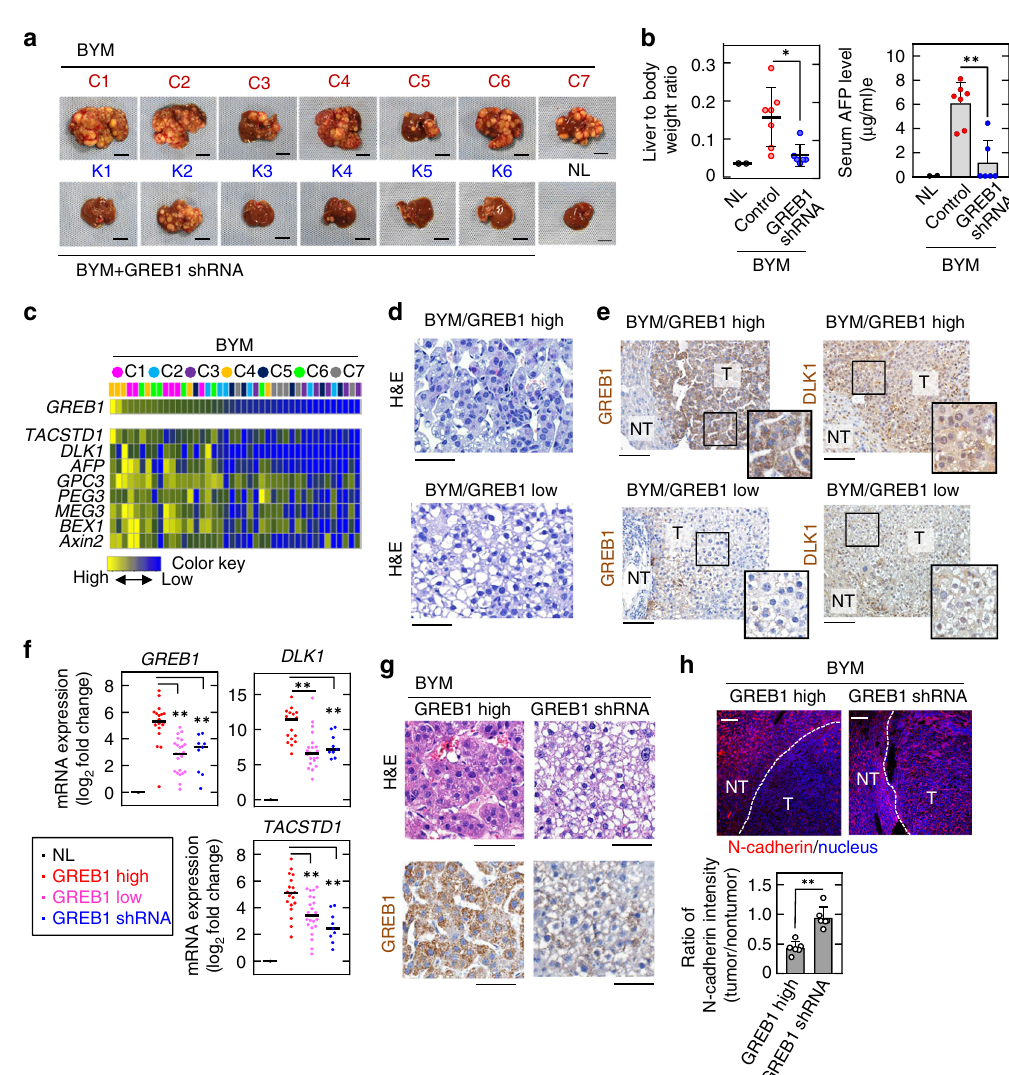
Fig. 7 GREB1 expression is involved in HB-like tumorigenesis in vivo. a Images of livers from untreated mice (NL) and mice injected with Δ N β -catenin, YAPS127A, and c-Met (BYM) with or without GREB1 shRNA at 8 weeks after hydrodynamic tail vein injection of plasmids. NL, normal liver; C, control; K, knockdown. b Weights of liver and whole body in untreated mice and BYM mice with or without GREB1 shRNA were measured and the results are expressed as liver weight to body weight ratio. Results are shown as dot plots with median± SD. Serum were prepared and the amounts of AFP levels were measured by ELISA. ** P < 0.01; * P < 0.05, t test. c Total RNA was prepared from six tumor nodules from seven BYM mice ( n = 42) and real-time PCR experiments for mRNA expression of indicated genes were performed. Results standardized by min – max normalization are shown as heatmap with the highest GREB1 expression on the left. d , e Tissue sections of the liver from BYM/GREB1 high (C4) and BYM/GREB1 low (C3) were stained with hematoxylin and eosin ( d ) or indicated antibodies and hematoxylin ( e ). Solid squares show enlarged images. NT nontumor, T tumor. f Total RNA samples were prepared from NL, tumor nodules from three BYM/GREB1 high, four BYM/GREB1 low, and two BYM with GREB1 shRNA mice. Real-time PCR analyses for mRNA expression of indicated genes were performed. The obtained results are expressed as log 2 fold changes compared with NL and results are shown as dots plot with median. ** P < 0.01, ANOVA and post hoc test. g Tissue sections of the liver isolated from the BYM mouse (C4) and the BYM mouse with GREB1 shRNA (K2) were stained with hematoxylin and eosin, or anti-GREB1 antibody and hematoxylin. h Tissue sections used in g were stained with anti- N-cadherin antibody and Hoechst33342. N-cadherin fl uorescence intensity in nontumor regions and tumor lesions were measured and the results are expressed as ratio of N-cadherin expression in tumor lesions to that in nontumor regions. ** P < 0.01, t test. Scale bars in a , 1 cm; in c and g , 50 μ m; in d